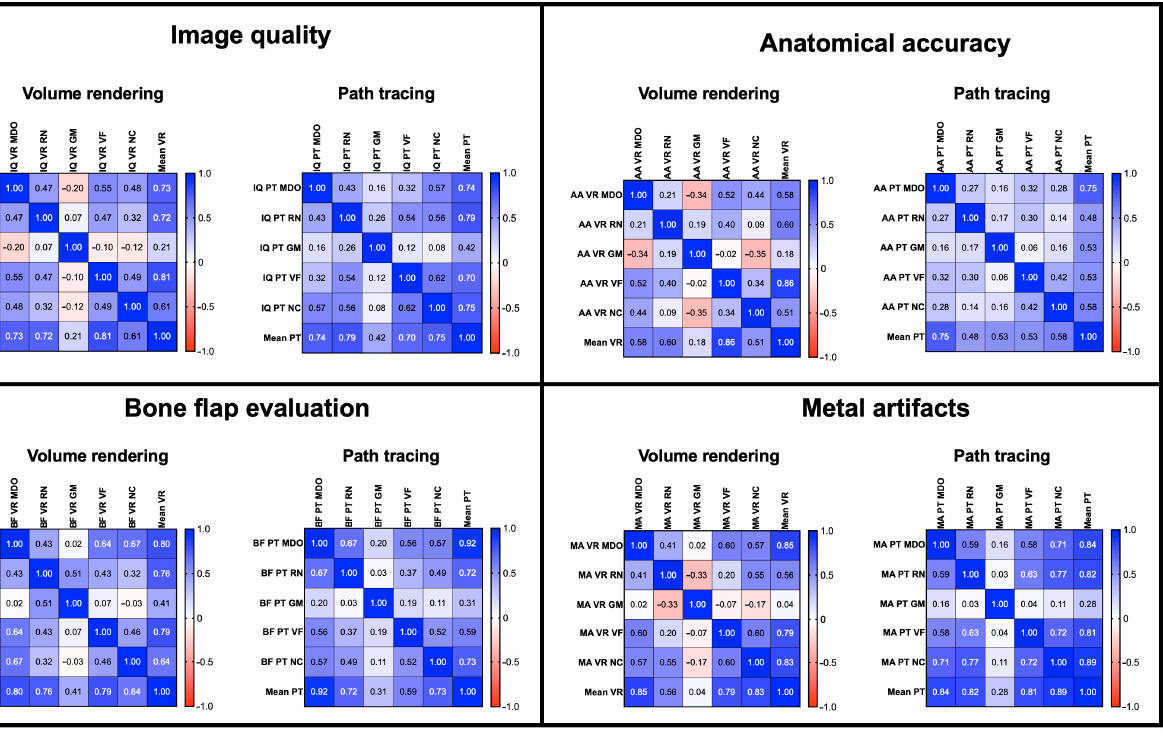
Figure 5. Inter-reader agreement correlation matrixes across all four parameters in VR and PT reconstructions (red negative correlation, blue positive correlation).